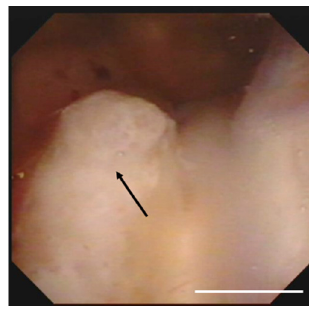
Figure 3. Operative findings showing a solid tumor (arrows) in the right lateral ventricle densely adherent to the choroid plexus. Scale bar, 1 cm.